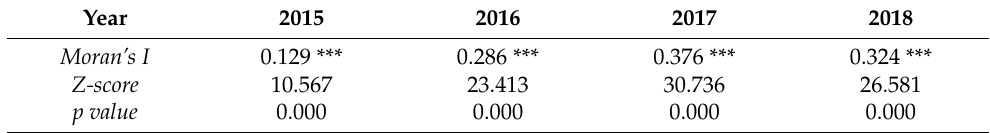
Table 2. Spatial–temporal dependence effects of poverty levels from 2015 to